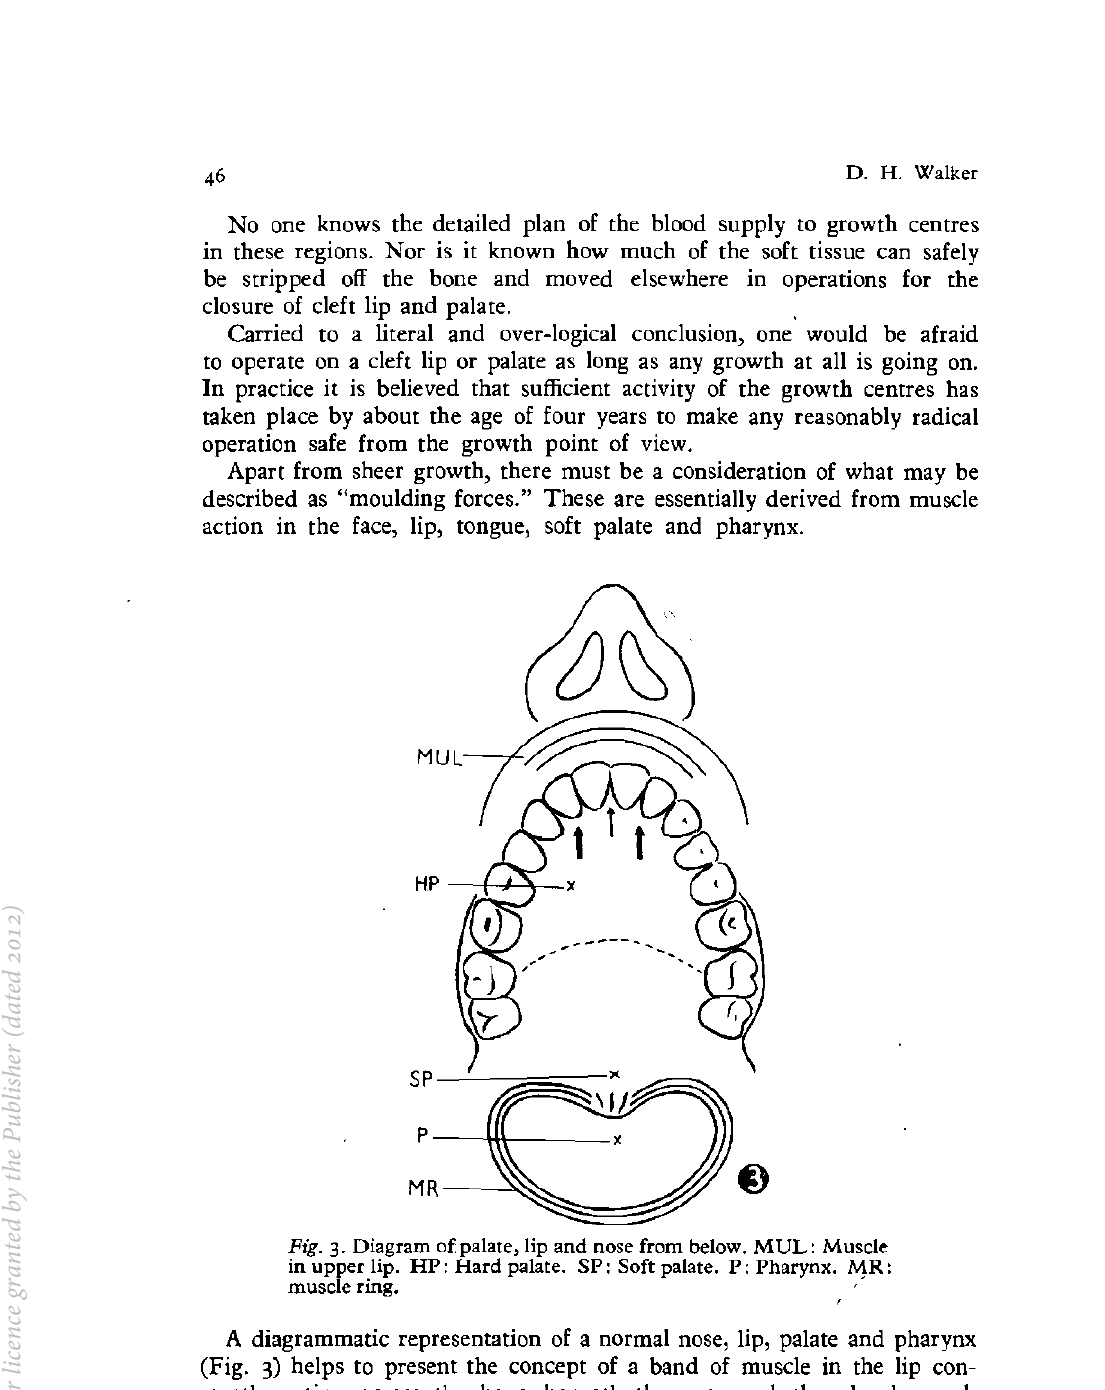
Fig. 3. Diagram of palate, lip and nose from below. MUL: Muscle in upper lip. HP: Hard palate. SP: Soft palate. Ρ: Pharynx. MR: muscle